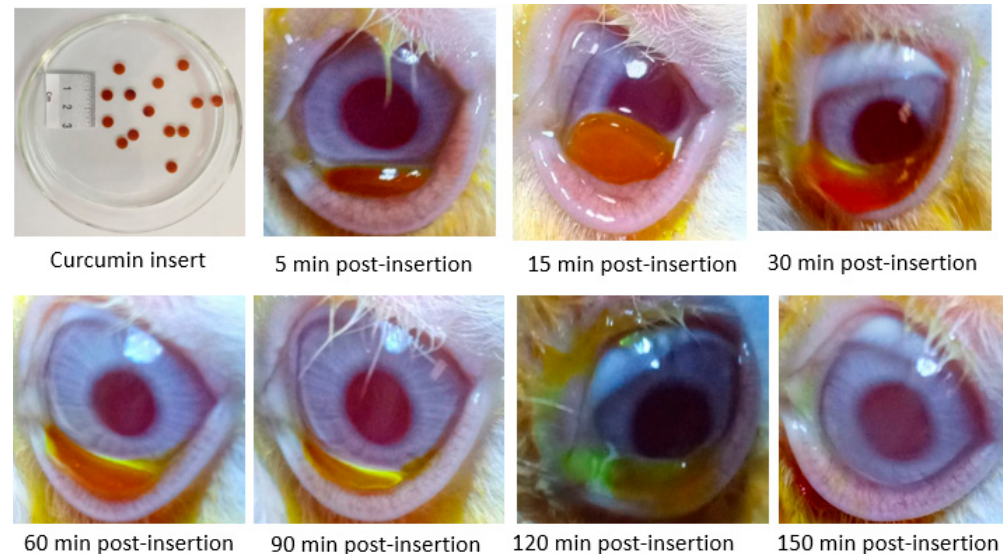
Figure 10. Real-time images demonstrating the in vivo residence/change of curcumin insert (F7) post insertion into the inferior conjunctival cul-de-sac of rabbit eye.